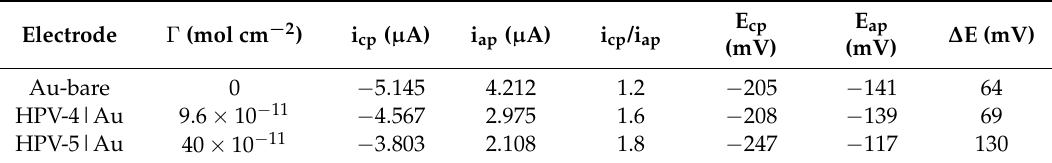
Table 2. Thermodynamic parameters for the process Ru ( NH 3 ) 3 + /2 + bare Au, HPV-4|Au and HPV-5|Au electrodes.